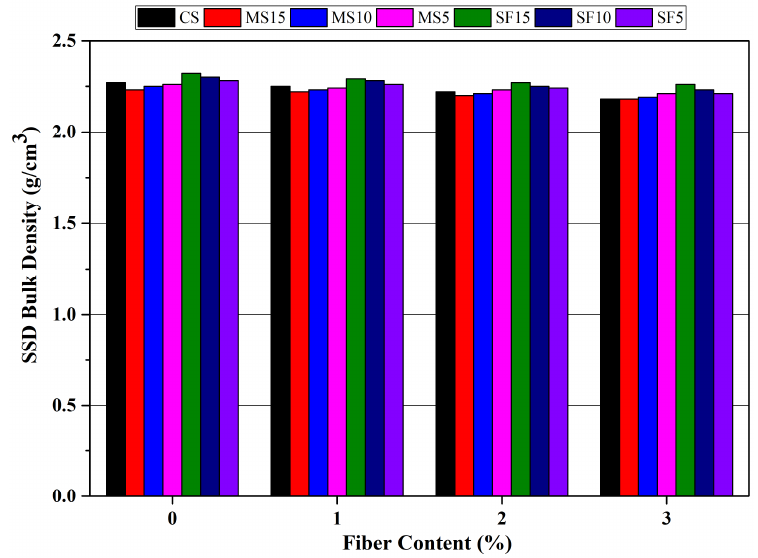
Figure 6. SSD bulk density values of the mortar samples